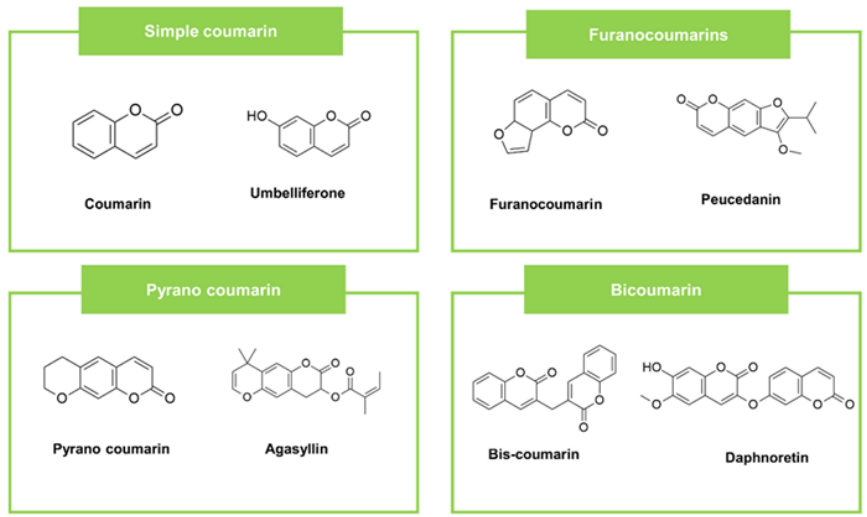
Figure 2. Representative chemical structures of different classes of coumarin and nature-derived coumarin.